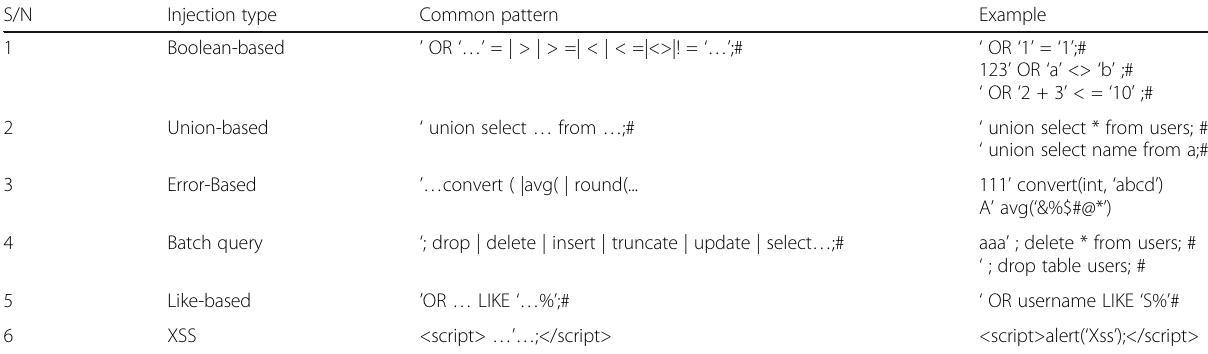
Table 3 Different forms of injection code with their common patterns